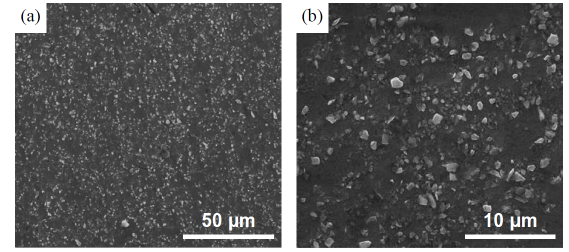
Figure 5: Tensile strength of SiCp/AZ31B composites fabricated by semi-solid stirring assisted ultrasonic vibration with different stirring time. Figure 6: SEM graphs of SiCp/AZ31B composites fabricated by semi- solid stirring assisted ultrasonic vibration with 20vol.% SiCp.